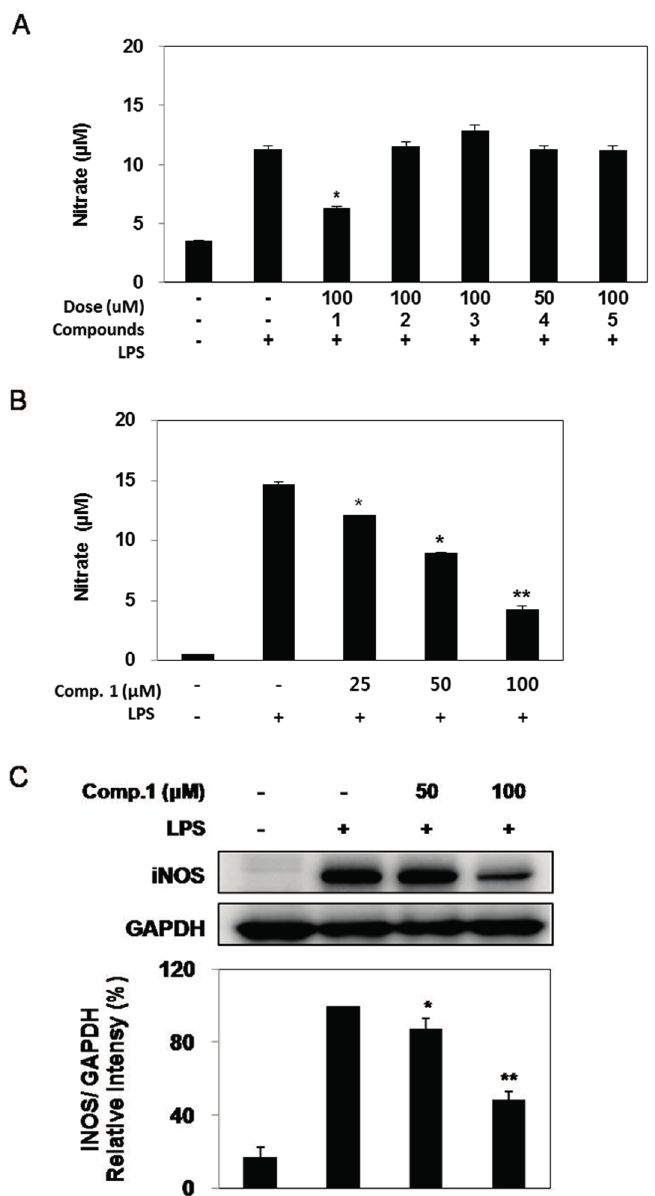
Figure 2. Effects of compounds 1 – 3 , 5 (100 μ M) and 4 (50 μ M) ( A ), and compound 1 (25–100 μ M) ( B ) on NO production by means of nitrite concentration and iNOS expression by means of protein expression levels ( C ) in LPS induced RAW 264.7 cells. RAW